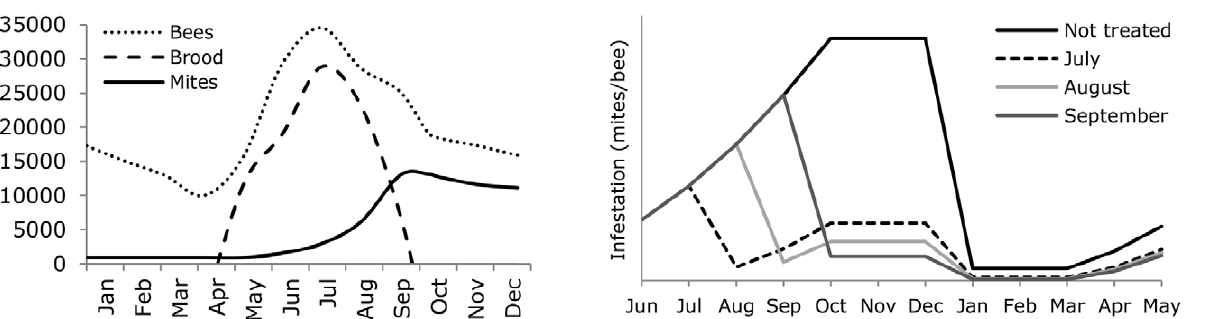
Figure 1. Colony development for adult bees, worker brood, and Varroadestructor mites. The daily number of individual adult bees (dotted line) and worker brood (striped line) was modelled over one year. The number of mites (solid line) was modelled as being the second year of mite infestation with a starting population of 100 mites in the first year. Figure was redrawn from Martin [9].